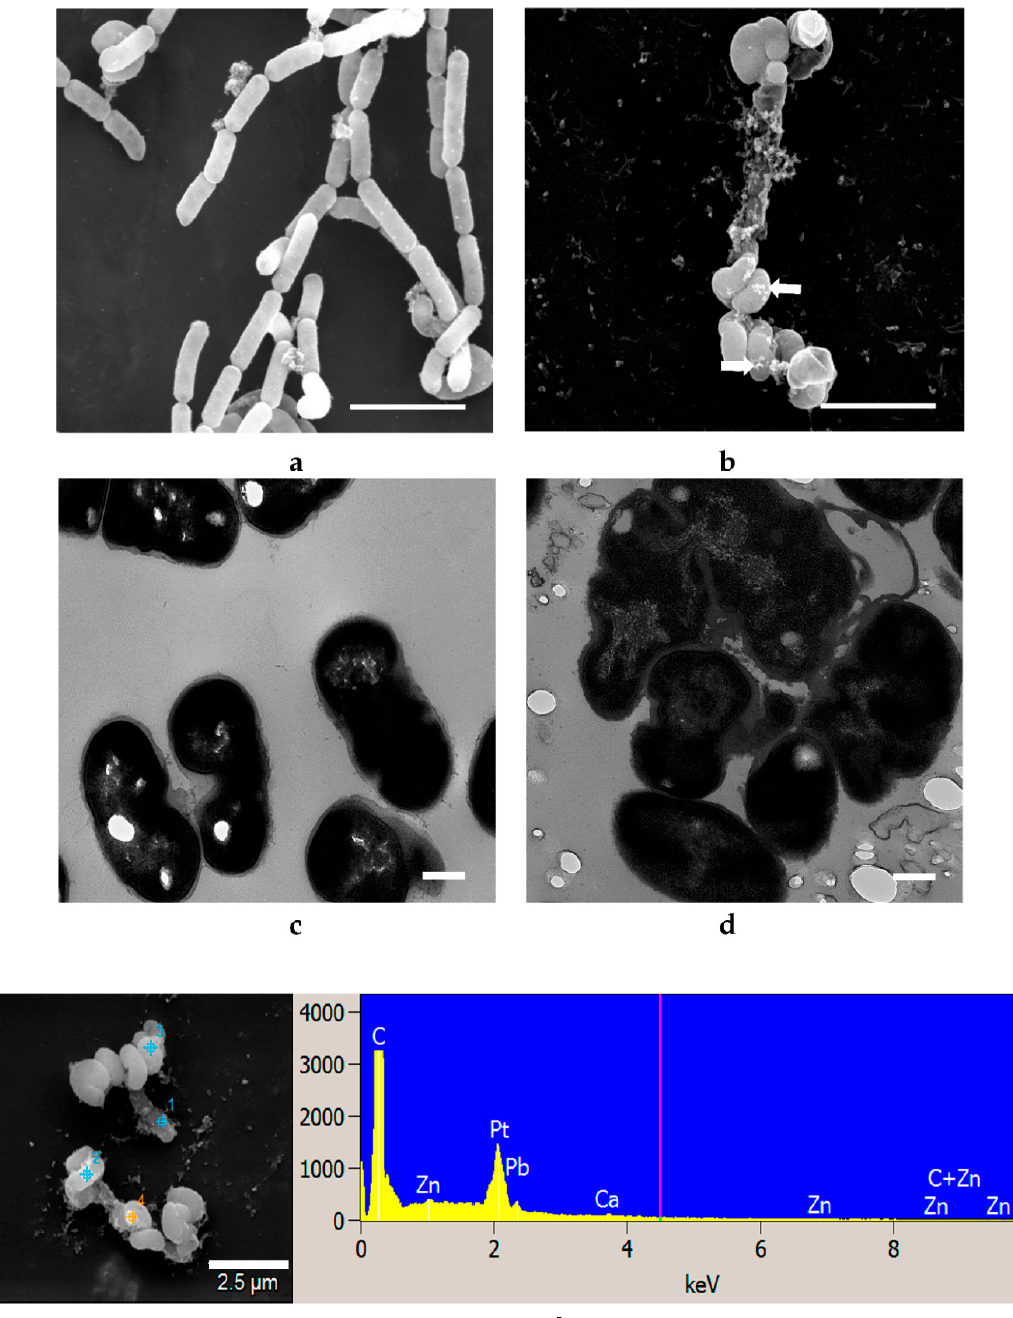
Figure 6. SEM ( a , b ) and TEM ( c , d ) images of B. animalis untreated with ZnO NPs ( a , c ) and treated with 20 mM ZnO NPs ( b , d ). SEM ‐ EDS analysis shows ZnO presence on cell surfaces ( e ). White arrows indicated clusters of ZnO NPs. SEM scale bar ( a , b ) = 3 μ m, TEM scale bar ( c , d ) = 0.2 μ m. No significant changes in the external appearance of E. coli cells were observed after treatment with Ag NPs for 6 h (Figure 7). Ag NPs were seen attached to the bacterial cells (arrows, Figure 7b) in clusters instead of singly. Similar agglomeration was observed for ZnO NP ‐ treated cells (Figures 4b and 5b). Untreated cells were normal in size with intact intracellular structures and well ‐ organized intracellular contents (Figure 7a,c). However,